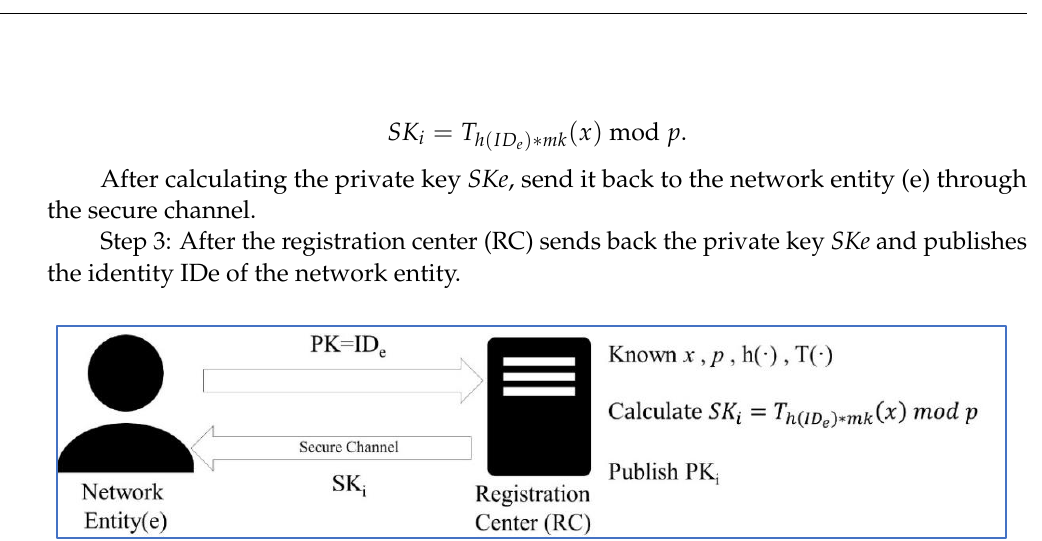
Figure 2. Network entity registration illustration diagram.